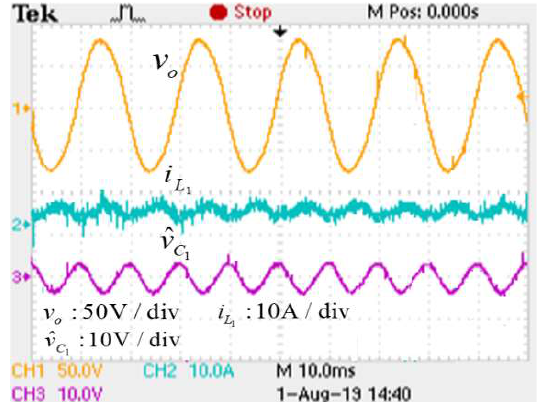
Figure 9. Experimental results with the CMS.